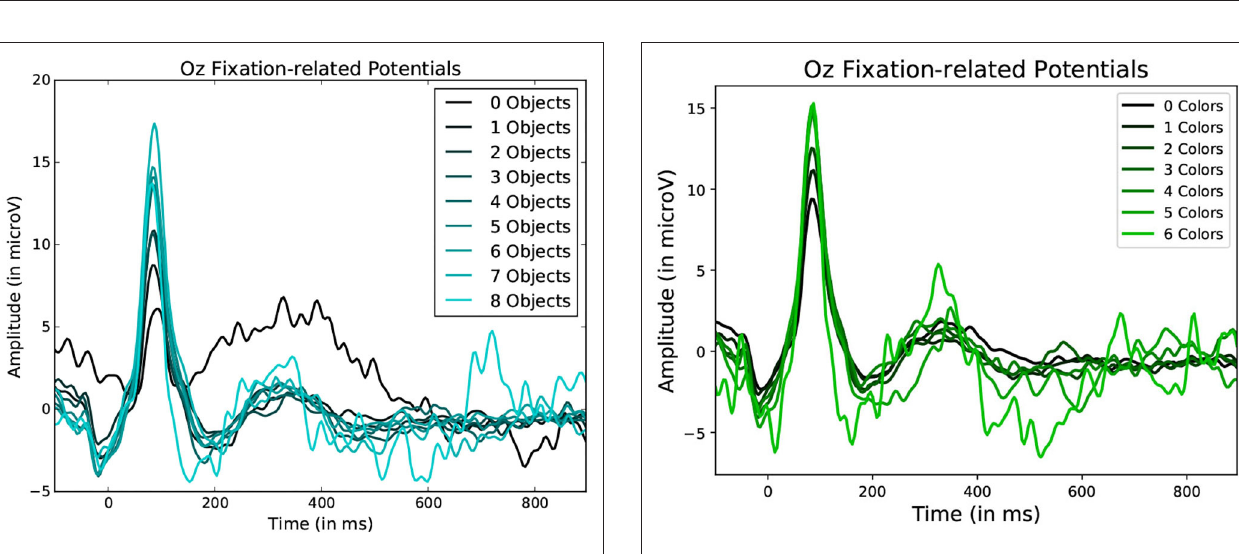
FIGURE 9 | Average fixation related potential epoch profiles recorded on the Oz electrode. The lighter the color, the more objects were present within the fixated region. Data from one participant was used in this figure.